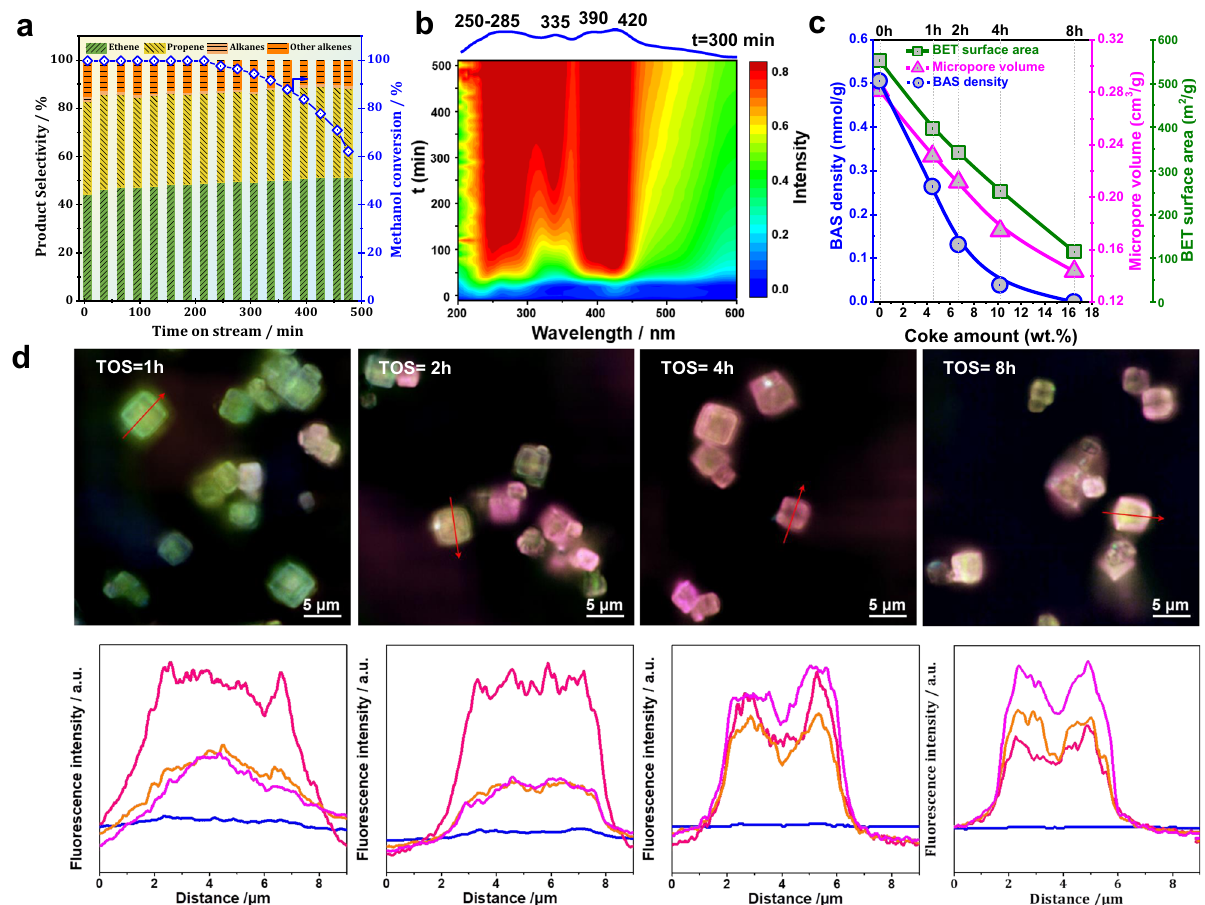
Fig. 1 Catalytic performance, organic intermediates, and textural properties of SAPO-34 catalysts. Methanol conversion and product distribution during the MTO conversion over SAPO-34 catalyst at 673 K ( a ). In situ UV-vis spectra of MTO conversion over SAPO-34 recorded at 673 K ( b ). In c , the number of accessible Brønsted acid sites, the BET surface area, and micropore volume of the SAPO-34 catalyst during the MTO conversion at 673 K are plotted as a function of coke amounts. In d , the spatiotemporal distribution of carbonaceous species obtained from SIM in SAPO-34 samples during the MTO conversion at 673 K for different TOS of 1 – 8 h. The fl uorescence intensities of the selected lines are also given. The SIM pictures are the fl uorescence originating from the overlap of four curves with different laser excitations of 405 nm (detection at 435 – 485 nm, blue curve), 488 nm (detection at 500 – 545 nm, pink curve), 561 nm (detection at 570 – 640 nm, orange curve), and 640 nm (detection at 663 – 738 nm, magenta